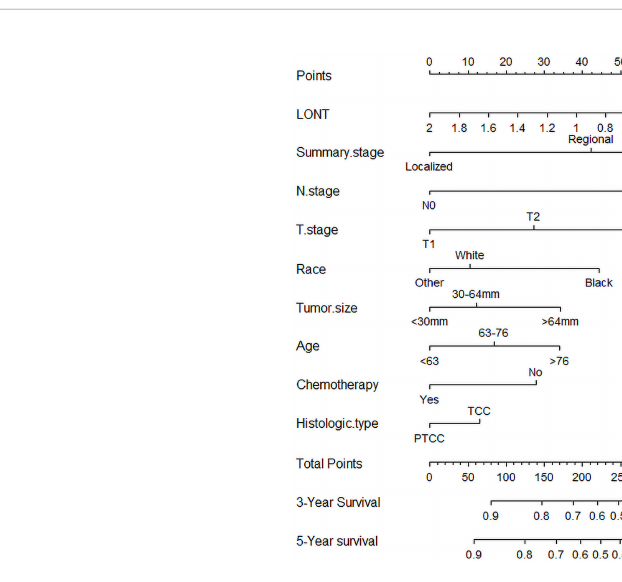
FIGURE 2 | Nomogram for predicting 3-, and 5-year cancer-speci fi c survival rate of bladder cancer patients after radical